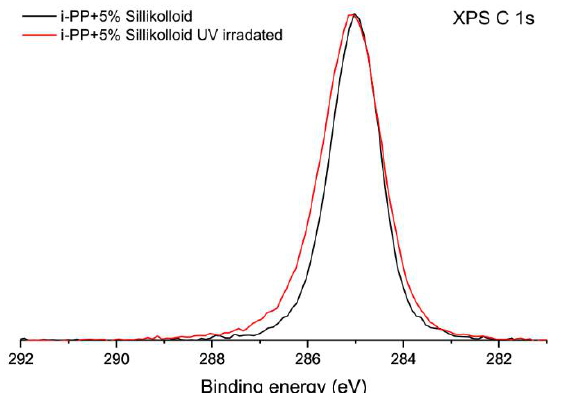
Figure 2. High-resolution X-ray photoelectron spectra of the unoriented i -PP + 5% of Sillikolloid in the energy range of the C 1s signal, black line—before ultraviolet (UV) treatment, red line—after one-month UV irradiation.